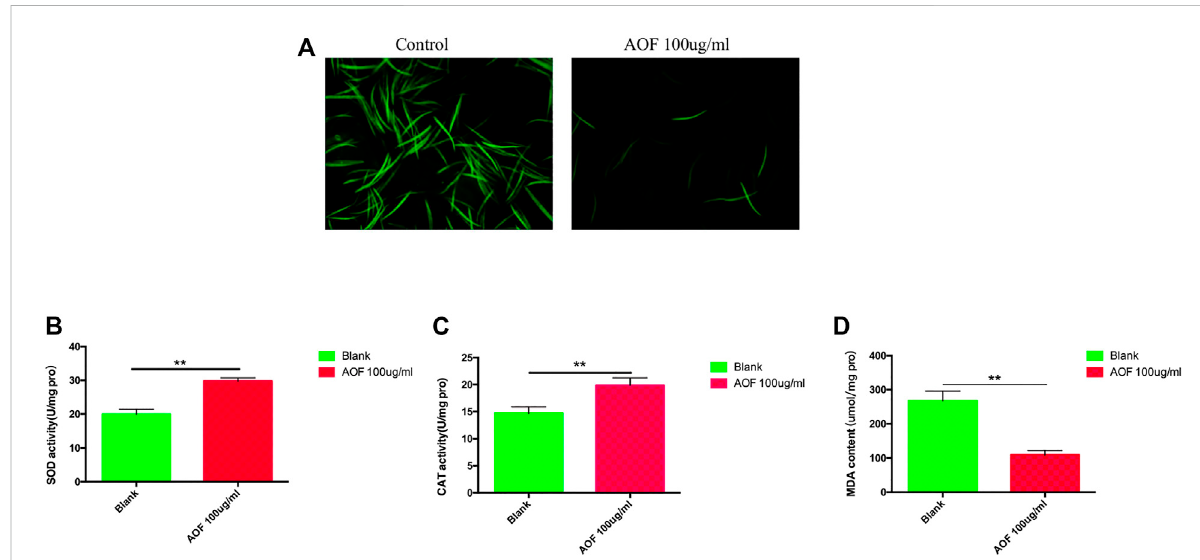
FIGURE 8 Antioxidant effects of AOF treatment of (C) elegans . (A) Effect of AOF on ROS-mediated fl uorescence. (B – D) Effect of AOF on the activities of antioxidant enzymes (B) SOD and (C) CAT, and (D) the level of MDA. Pro = protein. Data are the mean ± SD ( n = 3). ** p < 0.01